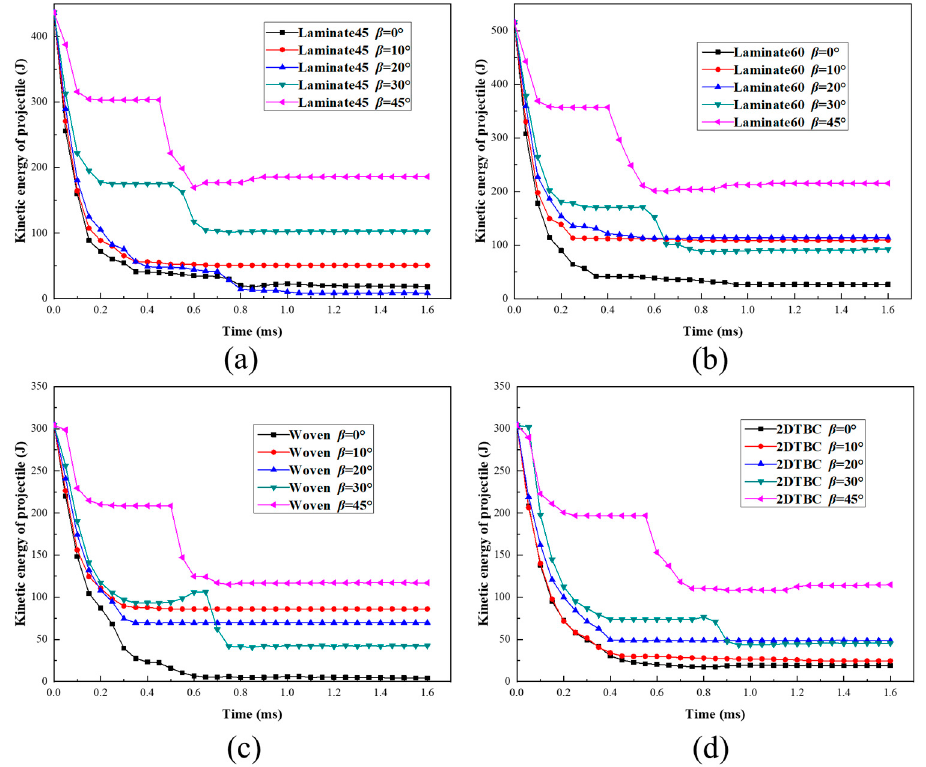
Figure 10. E ff ect of deflection angle on the kinetic energy profile of di ff erent composite panels, under Figure 10. Effect of deflection angle on the kinetic energy profile of different composite panels, under critical impact velocities: ( a ) Laminate45 at V cr,n = 115 m / s, ( b ) Laminate60 at V cr,n = 125 m / s, ( c ) woven critical impact velocities: ( a ) Laminate45 at V cr,n =115m/s, ( b ) Laminate60 at V cr,n =125m/s, ( c ) woven panel at V cr,n = 115 m / s, ( d ) 2DTBC panel at V cr,n = 115 m / panel at V cr,n =115m/s, ( d ) 2DTBC panel at V cr,n =115m/s.